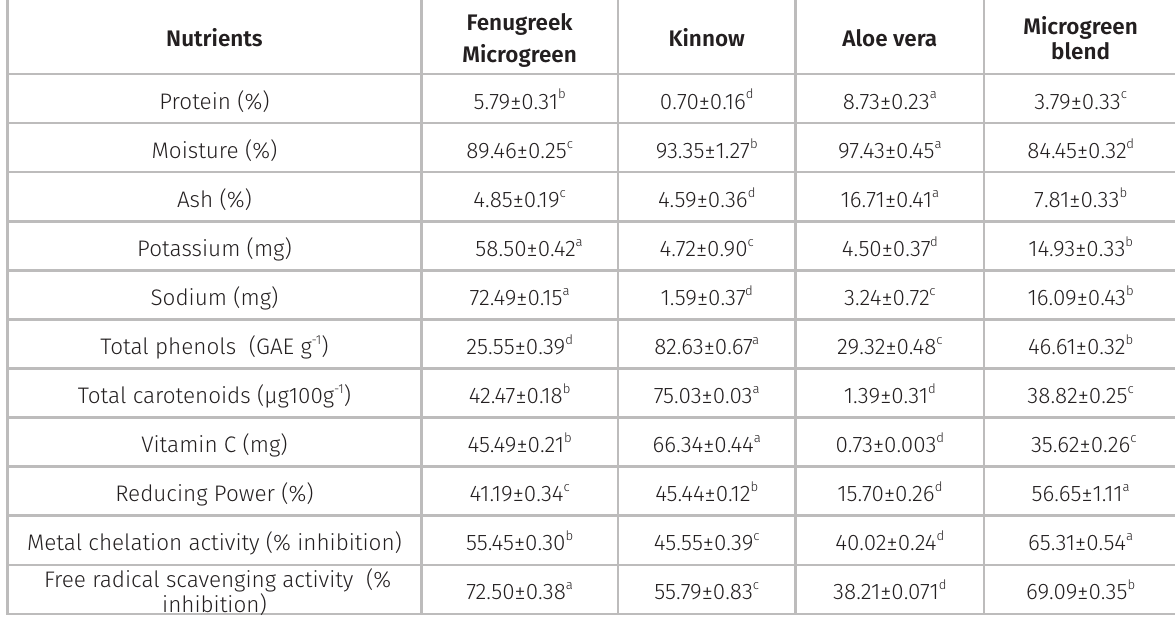
Table VI. Nutritional values of fenugreek microgreens, kinnow, aloe vera and microgreen